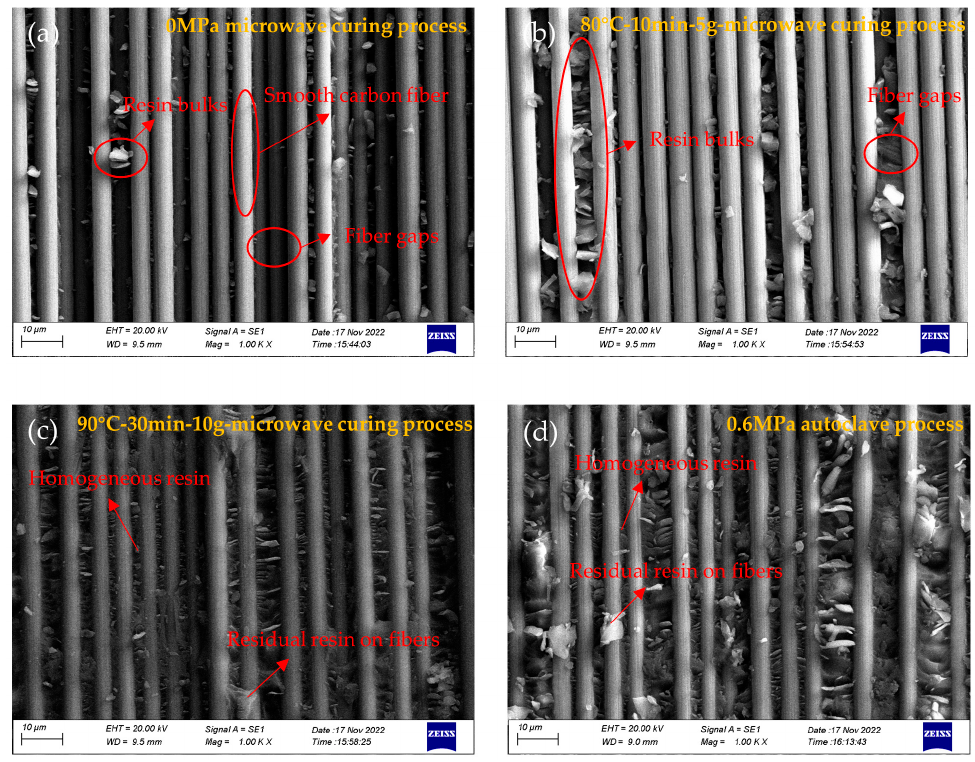
Figure 8. SEM of three ‐ point bending fracture surface under different curing processes, ( a ) 0 MPa microwave curing process, ( b ) 80 ◦ C-10 min-5 g microwave curing process, ( c ) 90 ◦ C-30 min-10 g microwave curing process, ( b ) 80 °C ‐ 10 min ‐ 5 g microwave curing process, ( c ) 90 °C ‐ 30 min ‐ 10 g microwave curing process, ( d ) 0.6 MPa autoclave microwave curing process, ( d ) 0.6 MPa autoclave process.